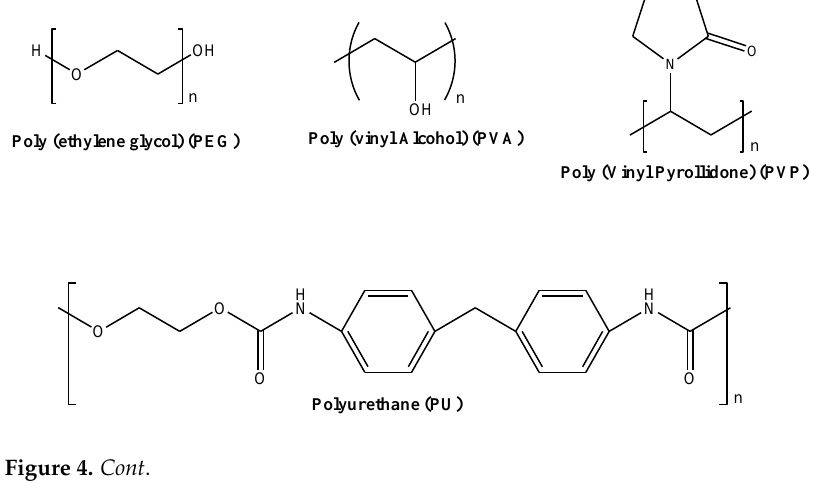
n Figure 4. Molecular structures of some synthetic polymers. 4. Different Forms of Hydrogels and Some Reported Progress in the Design of Hydrogels Hydrogels are three-dimensional network scaffolds that are composed of hydrophilic polymers with excellent swelling and absorption capacity of water and other biological fluids without dissolving (Figure 5) [34]. Hydrogels consist of around 90% water and 10% synthetic or natural polymers; this high water content makes them wound dressings ap- propriate for the treatment of necrotic and dry injuries [35]. These scaffolds have been widely employed in biomedical and pharmaceutical applications because of their ability to accurately mimic the natural ECM properties. Consequently, in wound dressing appli- cations, hydrogels not only provide a physical barrier with a good absorption capacity of excess wound exudate but can also be loaded with bioactive agents and offer a moist en- vironment that stimulates the process of wound healing [36,37]. Furthermore, injectable hydrogels can completely cover irregular-shaped injuries and deep bleeding wounds more effectively [38]. Due to the many benefits of hydrogels, a series of hydrogels that are commercially available for wound treatment have been developed, such as Coseal ® , Evicel ® , Tegaderm TM hydrocolloid dressing, and Algisite M [39]. The novel hydrogel ma- terials with various properties (e.g., biodegradability, antibacterial ability, promote